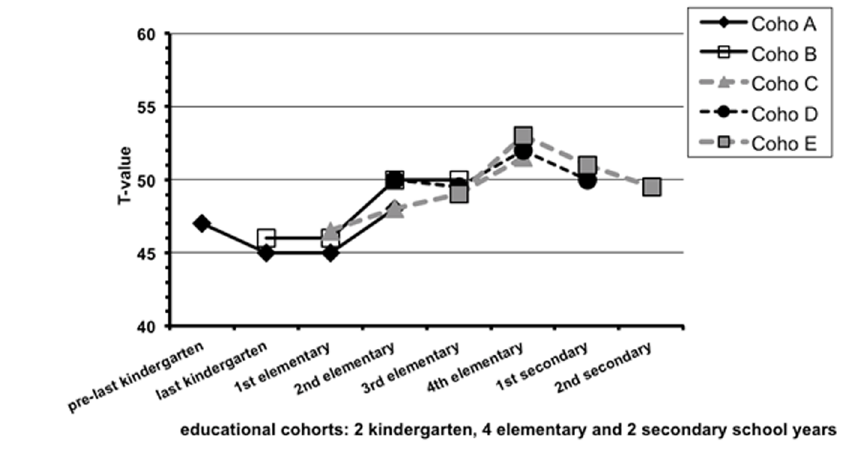
Figure 2. Cross-sequential results on dysthymic mood (DM) in the German sample.